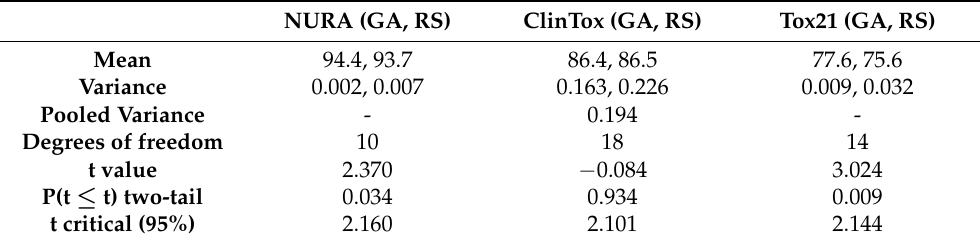
Table A4. Two-tailed t-test with a hypothesized zero mean difference for the three datasets consid- ering the best result among 10 replicas between genetic algorithms (GA) and random search (RS) on the external test set. Variances were assumed unequal for Tox21 and NURA ( p -value of F test 0.04 and 0.02).